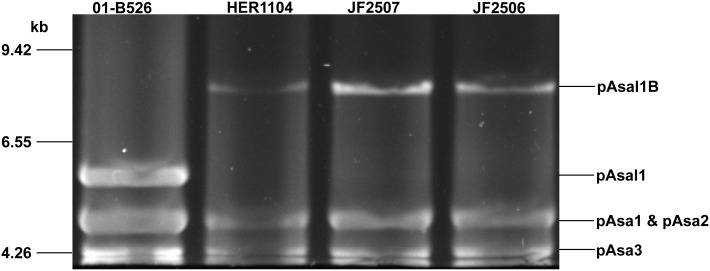
Pulse field gel electrophoresis of digested small plasmids. The purified small plasmids of isolates JF2506 and JF2507 were digested with EcoRI and were separated on 1% agarose gel by PFGE. HER1104 was also added since the bands were similar to those reported for the pAsal1 variant pAsal1B. Strain 01-B526 was used as a control of a normal plasmidome of small plasmids.